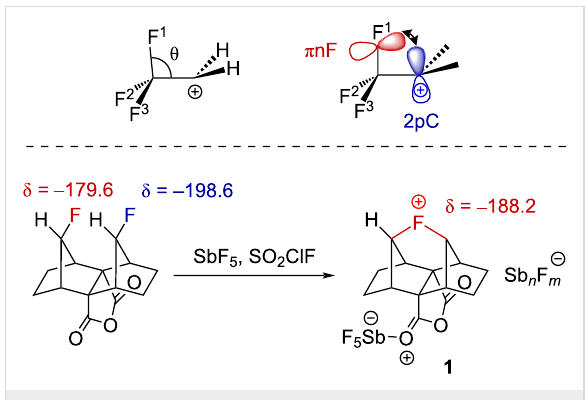
Figure 1: Stabilizing interaction in the CF 3 CH 2 + carbenium ion (top) and structure of the first observable fluoronium ion 1 (bottom) ( δ in